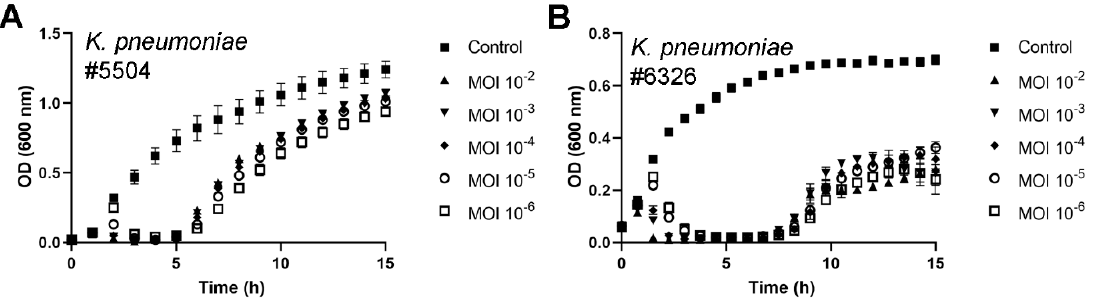
Figure 3. Growth curves of Klebsiella pneumoniae strains #5504 ( A ) and #6326 ( B ) infected with fHe-Kpn01. Bacteria were cultured with di ff erent initial multiplicities of infections (MOIs) in liquid LB-medium at 37 ◦ C. Each data point represents the average optical density (OD) at 600 nm for four to five replicates and error bars represent the standard deviation (SD).